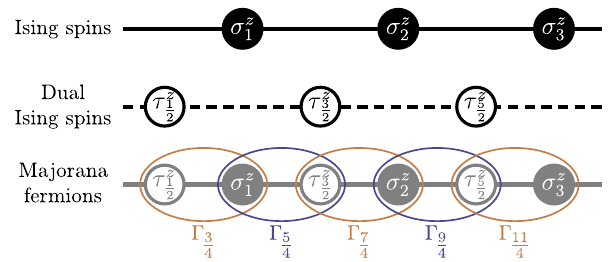
FIG. 4. Different sets of variables for representing the transverse- field Ising model. Microscopic Ising spins reside on sites labeled by integers. Dual Ising spins reside on the dual lattice sites denoted by half-integers. Majorana fermions are obtained by combining direct Ising spins with dual Ising spins and are thus most naturally associated with sites labeled by